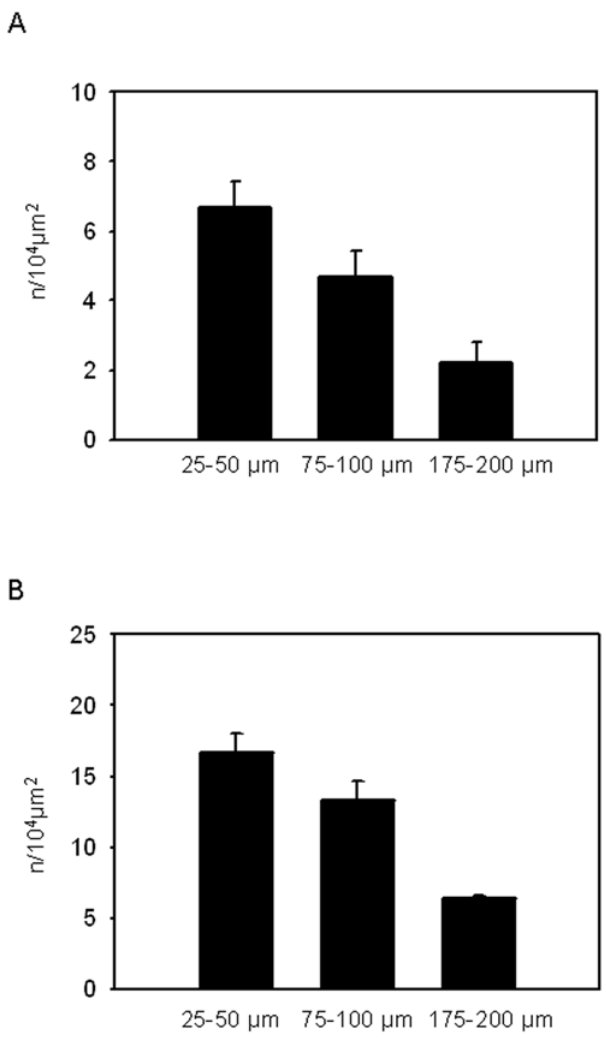
Figure 1. Dependency of leukocyte adhesion and transmigra- tion on the distance of microinjection from the vessel. Leukocyte adhesion (A) and transmigration (B) were analyzed 60 min after microinjection of MIP-1 a performed at distances of 25–50, 75–100, and 175–200 m m from the postcapillary venule. Both parameters were observed in ROIs (100 6 50 m m) along the venule (mean 6 SEM;